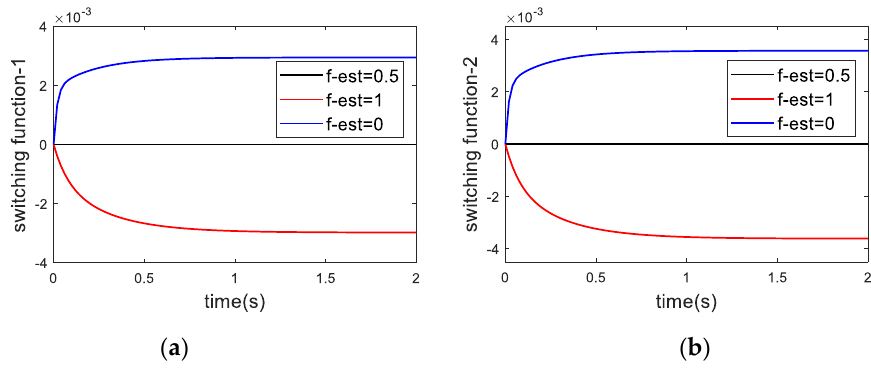
Figure 11. Switching function in different FC situations. ( a ) first term ( b ) second term.